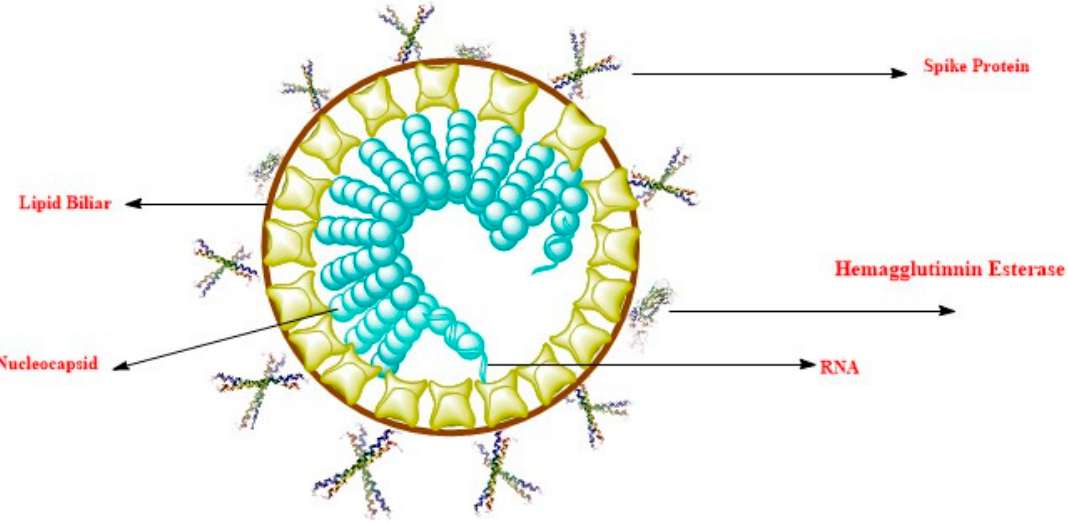
Figure 1. Structure of coronavirus virion showing the spike protein, membrane glycoprotein, lipid bilayer, nucleocapsid, envelope glycoprotein, RNA, and hemagglutinin esterase.